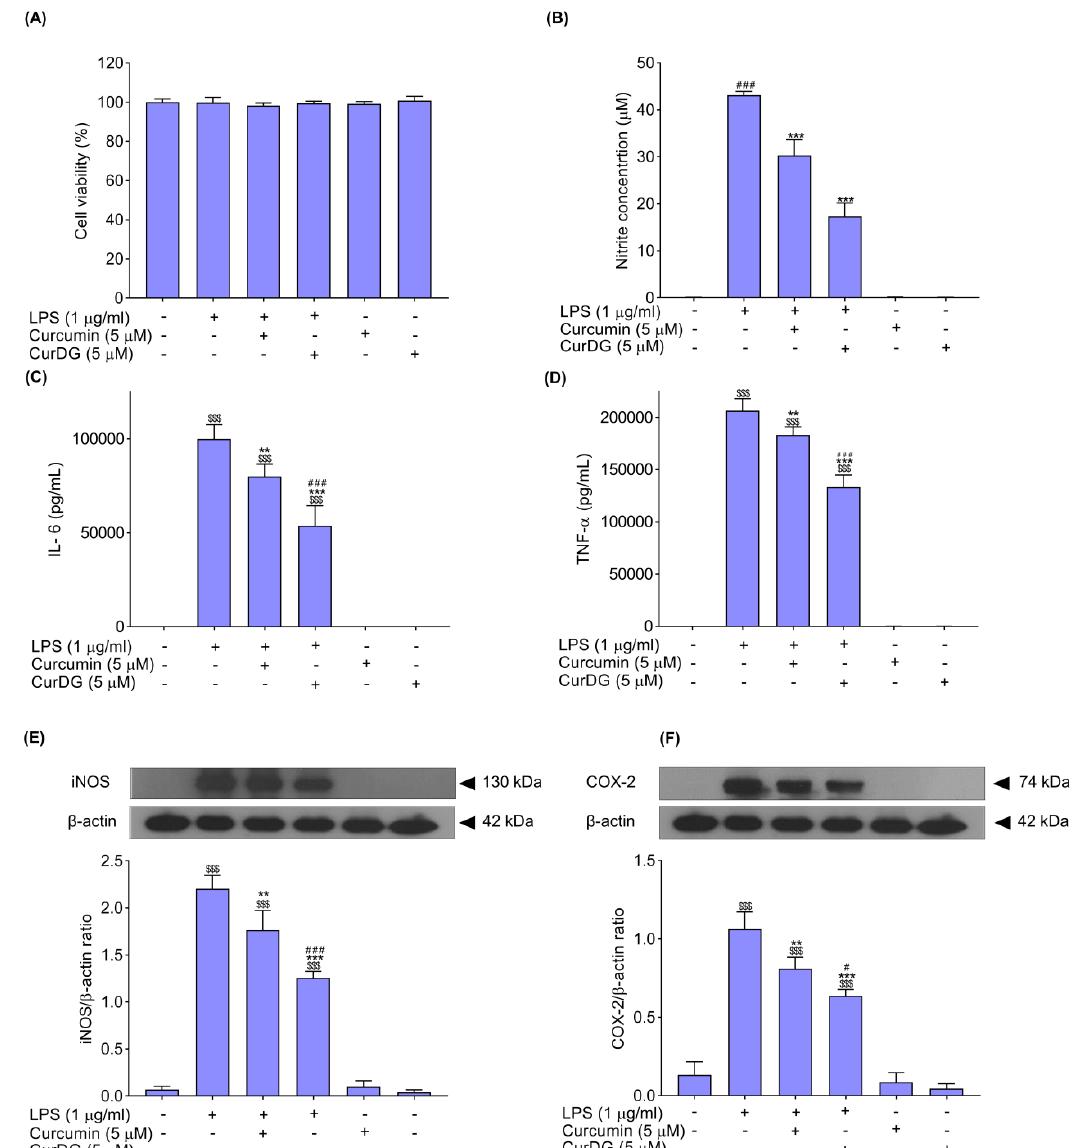
Figure 3. E ff ects of curcumin and CurDG on cell viability ( A ), NO production ( B ), and proinflammatory cytokine and mediator expression in LPS-stimulated RAW 264.7 cells. Cells were pre-treated with 5 µ M curcumin or CurDG for 1 h, followed by the addition of 1 µ g / mL LPS for 24 h. The culture medium was collected for NO determination and the cells were determined for cell viability with MTT assays. The IL-6 ( C ) and TNF- α ( D ) levels measured by ELISA assay are presented in pg / mL. The expression of iNOS ( E ) and COX-2 ( F ) proteins were determined by Western blot analysis, and these graphs were analyzed using the ImageJ software. The values of iNOS and COX-2 proteins were normalized with β -actin. The data present the mean ± SD, n = 3 of three independent experiments. Note: $$$ p < 0.001 compared to the control group and ** p < 0.01; *** p < 0.001 compared to the LPS control group and # p < 0.05; ### p < 0.001 significant di ff erence between curcumin- and CurDG-treated